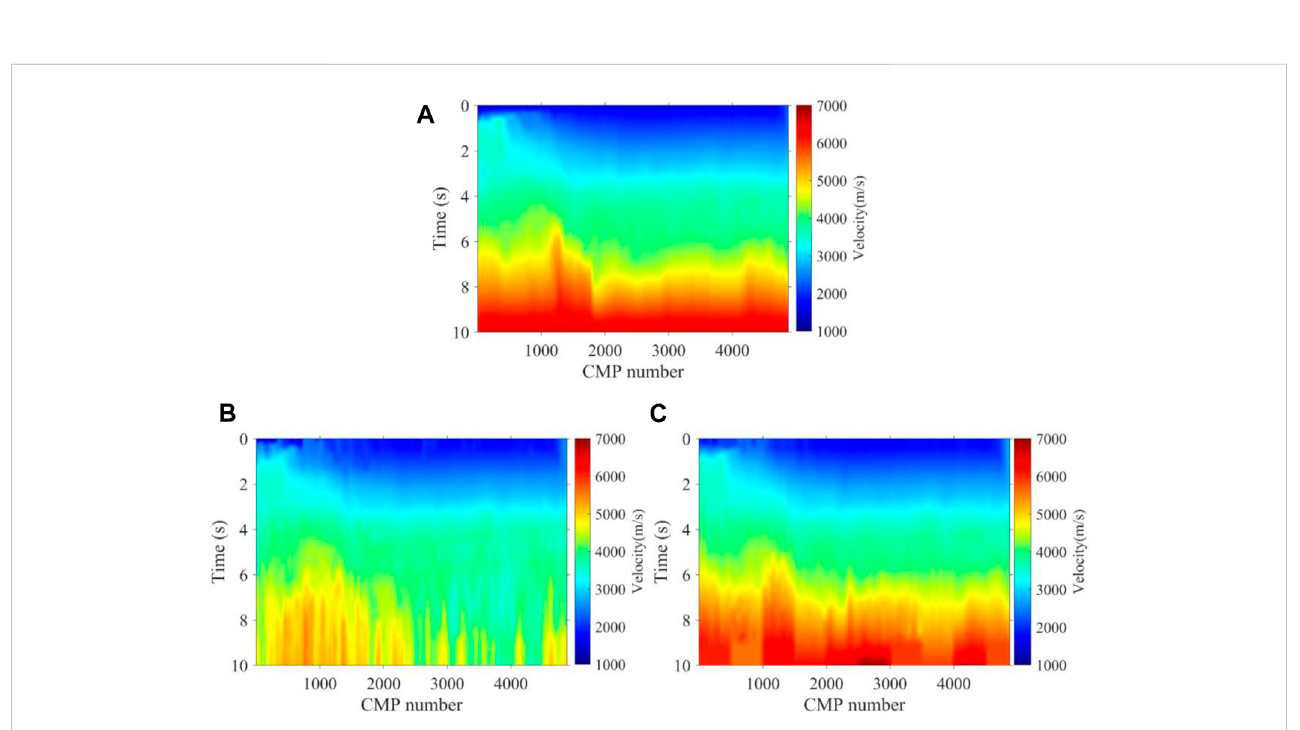
FIGURE 15 Velocity fi eld of a 2D real data established by (A) manual, (B) K-means, and (C) the method proposed.